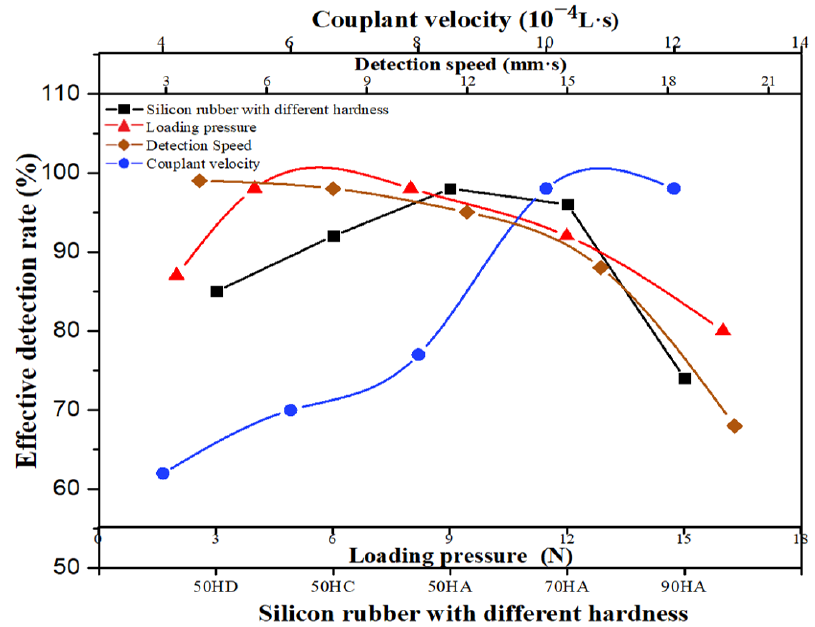
Figure 20. Effective detection rate of test device.